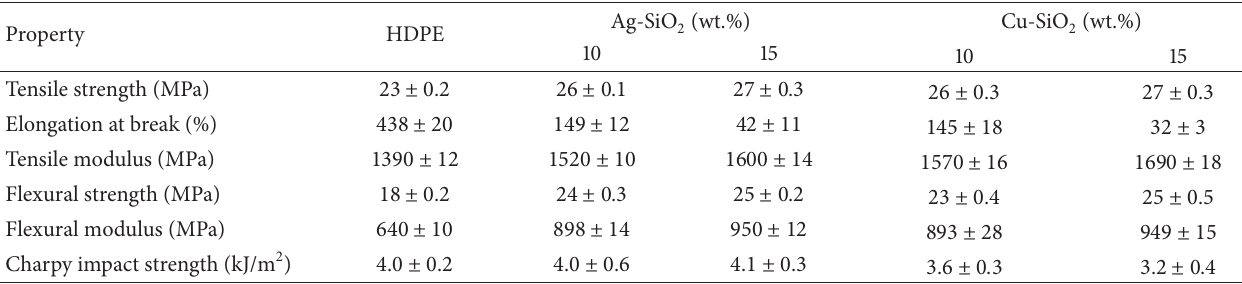
Table 7: Tensile, flexural and impact properties of HDPE and the HDPE composites containing Ag-SiO testing speed 5mm/min.